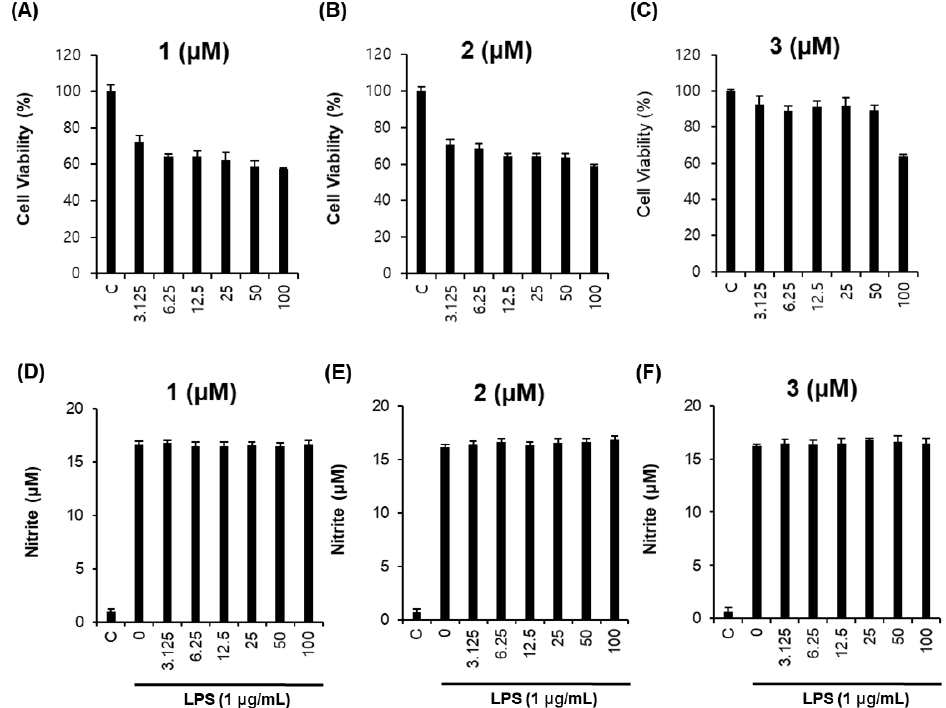
Figure 4. Inhibitory effects of compounds 1 – 3 on lipopolysaccharide (LPS)-induced NO production in RAW264.7 cells. (A–C) Effects of compounds 1 – 3 on cell viability. (D–F) Inhibitory effects of compounds 1–3 on LPS-induced NO production in RAW264.7